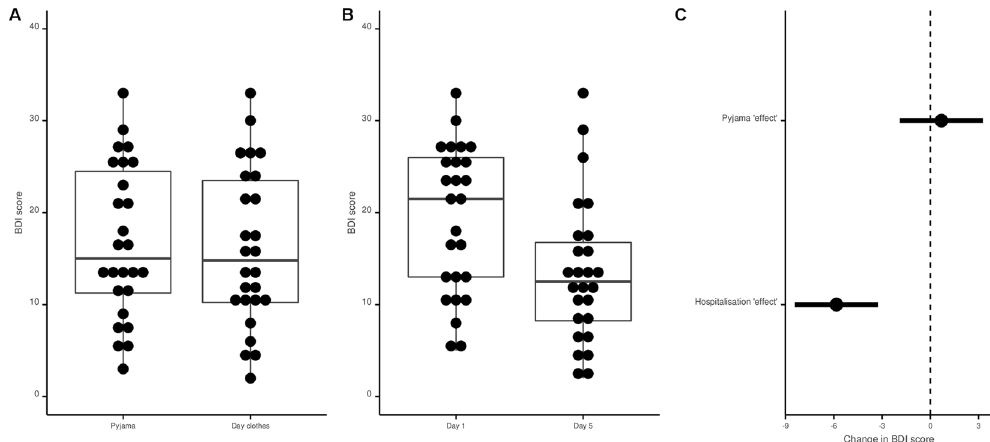
Figure 4. Pyjama and hospitalization effects on the Beck Depression Inventory (BDI). Panel A: Distribution of BDI scores in the day clothes and pyjama conditions. Panel B: Distribution of BDI scores at Day 1 and Day 5. Panel C: BDI analysis; forest plot of coefficients and their 95% confidence interval observed with a mixed model (mixed model performed with the “patient” factors specified as random